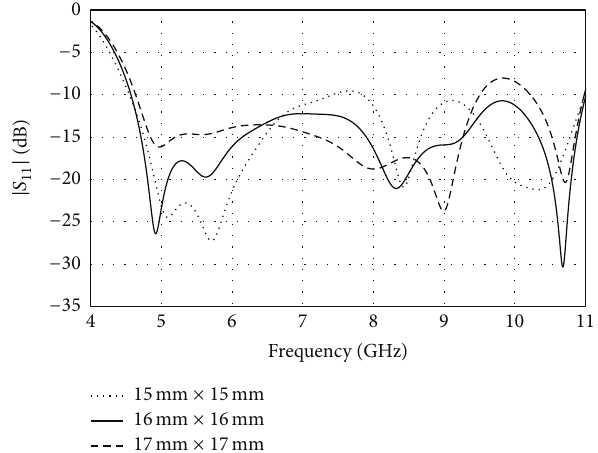
Figure 8: Simulated reflection coefficient for various substrate